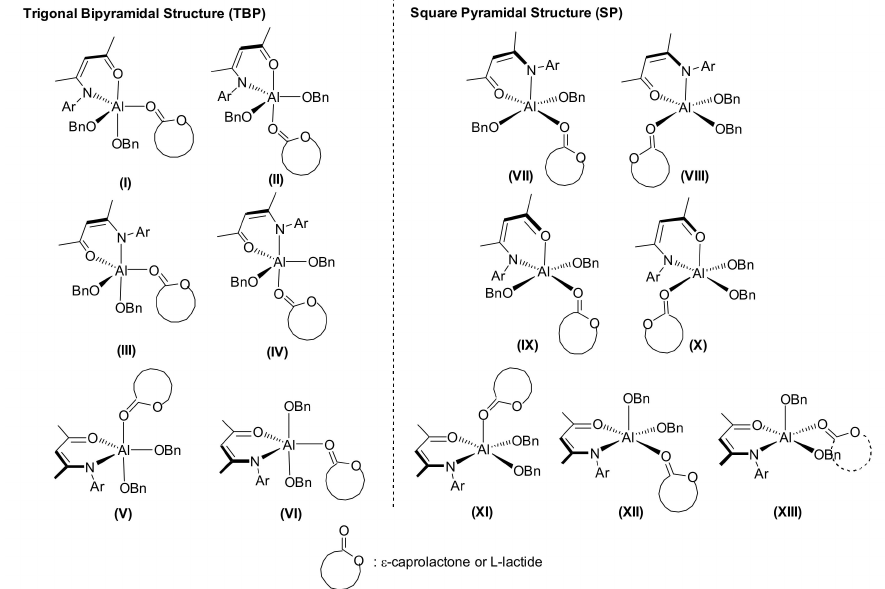
Figure 3. Thirteen possible initial geometries considered in this